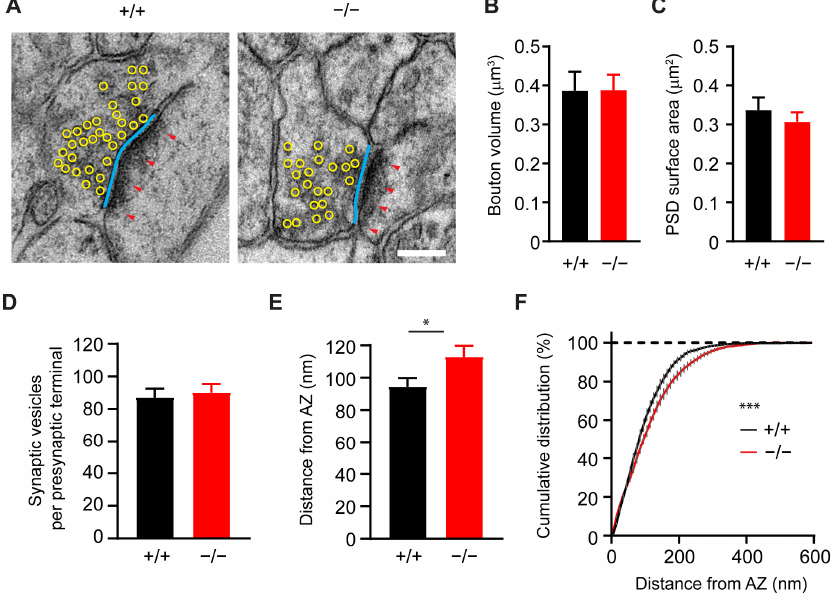
Figure 4. Astroglial Cx43 deficiency disrupts the distribution of synaptic vesicles in presynaptic terminals. ( A ) Representative electron micrographs of hippocampal presynaptic terminals (boutons) in wild-type (+/+, left) and Cx43 − / − ( − / − , right) mice. Yellow circles outline the synaptic vesicles; blue lines mark active zones; and red arrowheads denote postsynaptic densities (PSD). ( B – D ) The plots show no signi fi cant di ff erence between the +/+ and − / − mice in terms of the bouton volume ( B ), PSD surface area ( C ), or in the number of synaptic vesicles per presynaptic terminal ( D ). ( E , F ) However, the distance of synaptic vesicles from the active zone (AZ) was found to be signi fi cantly greater in the − / − mice when compared to the +/+ mice, as can be seen when this is plo tt ed in averages ( E ) and cumulative histograms ( F ). The distance was determined as the minimal distance between the center of each synaptic vesicles to the corresponding presynaptic membrane opposing the PSD. Mean ± SEM; n = 60 (+/+) and 62 ( − / − ) terminals in ( B , C ), as well as the 33 (+/+) and 45 ( − / − ) terminals in ( D – F ). From 3 +/+ and 3 − / − mice; * p < 0.05, *** p < 0.001; and scale bar: 0.15 µm in ( A ).